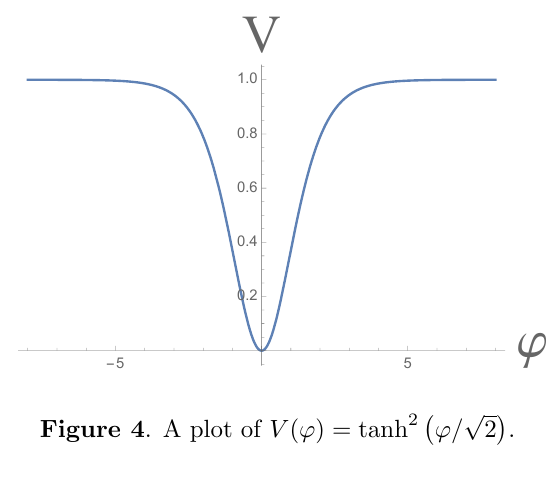
Figure 4 . A plot of V ( ’ ) = tanh 2